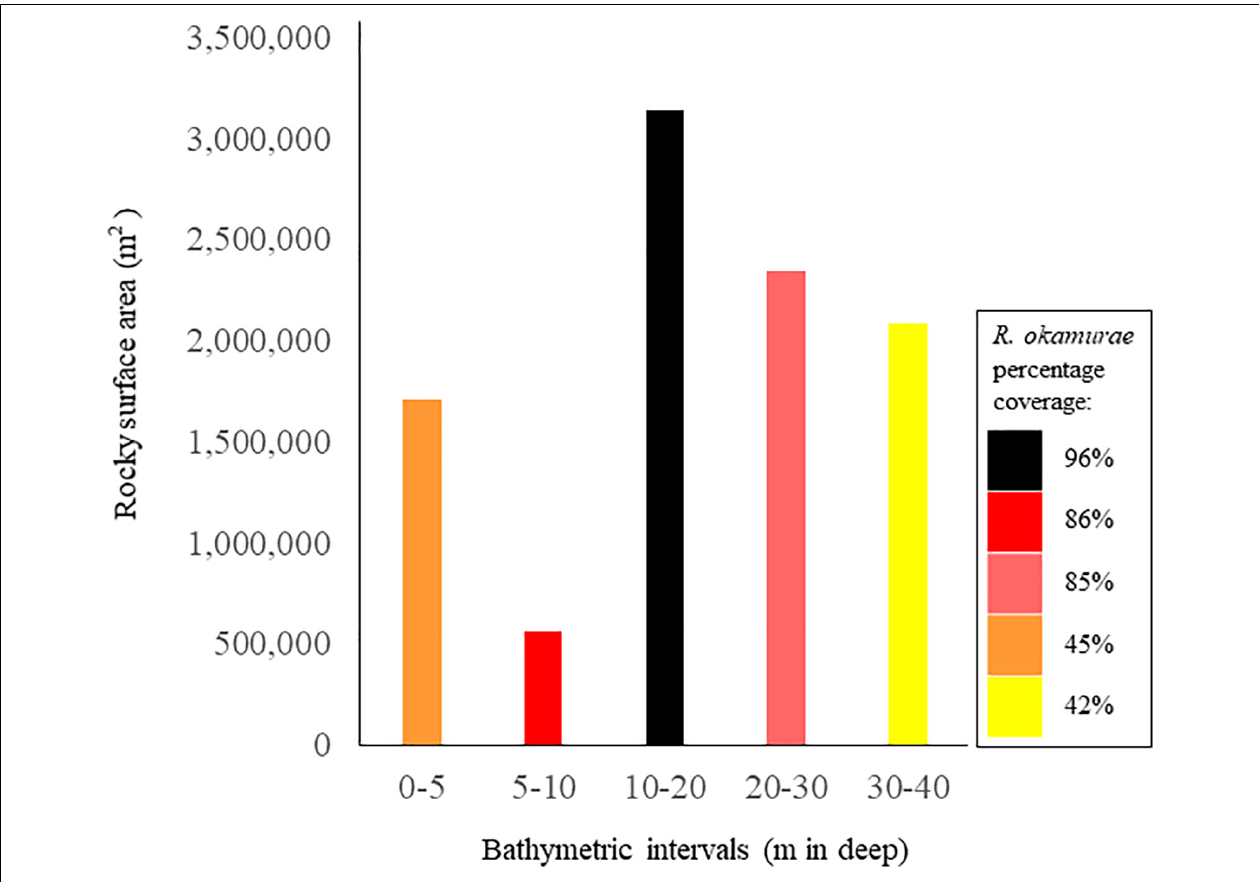
FIGURE 7 | Rocky surface areas (m 2 ) obtained for each bathymetrical interval (m) of the sublittoral coastline of the PNE. Colors legend represent the different percentage coverage values obtained for each bathymetrical interval mapped for the northern Strait of Gibraltar coastline (see Figure 5